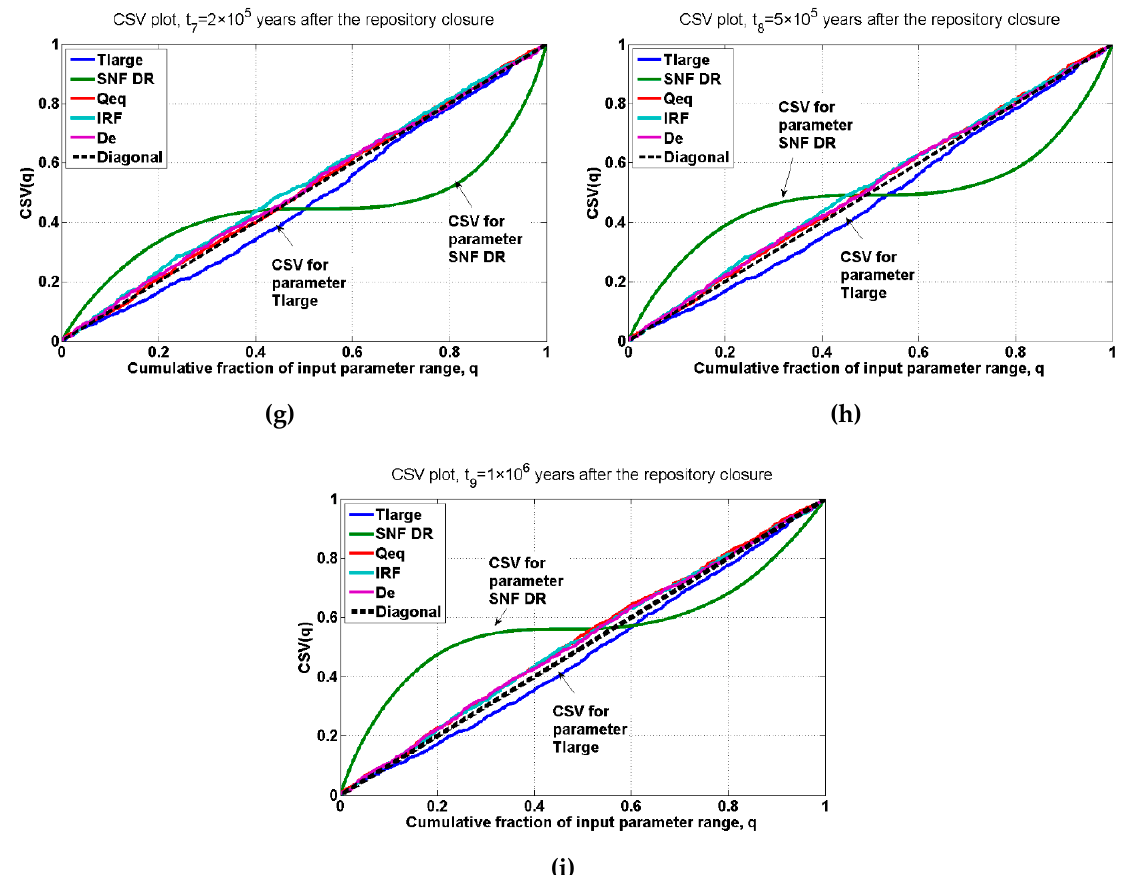
Figure 5. The CSV (contribution to sample variance) plots for I-129 radionuclide flux into the geosphere (random sample size N = 1000) at di ff erent time points after the repository closure: ( a ) at 1 × 10 3 years after repository closure; ( b ) at 5 × 10 3 years after repository closure; ( c ) at 1 × 10 4 years after repository closure; ( d ) at 2 × 10 4 years after repository closure; ( e ) at 5 × 10 4 years after repository closure; ( f ) at 1 × 10 5 years after repository closure; ( g ) at 2 × 10 5 years after repository closure; ( h ) at 5 × 10 5 years after repository closure; ( i ) at 1 × 10 6 years after repository closure (Tlarge—defect size